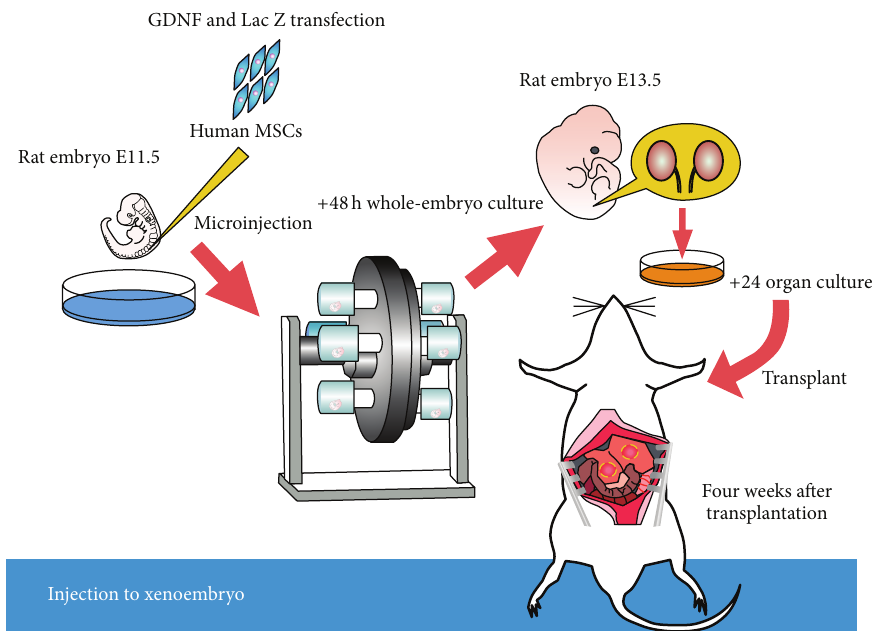
Figure 2: Strategy for nephron regeneration. MSCs were injected at the site of sprouting of the ureteric bud in E11.5 rat embryos. These embryos were then developed in whole-embryo culture for 48 h. Development of a neokidney derived from hMSCs in rat embryos. A kidney anlagen derived from MSCs was transplanted into the adult rat omentum. After culturing, hMSCs formed a neokidney in the rat